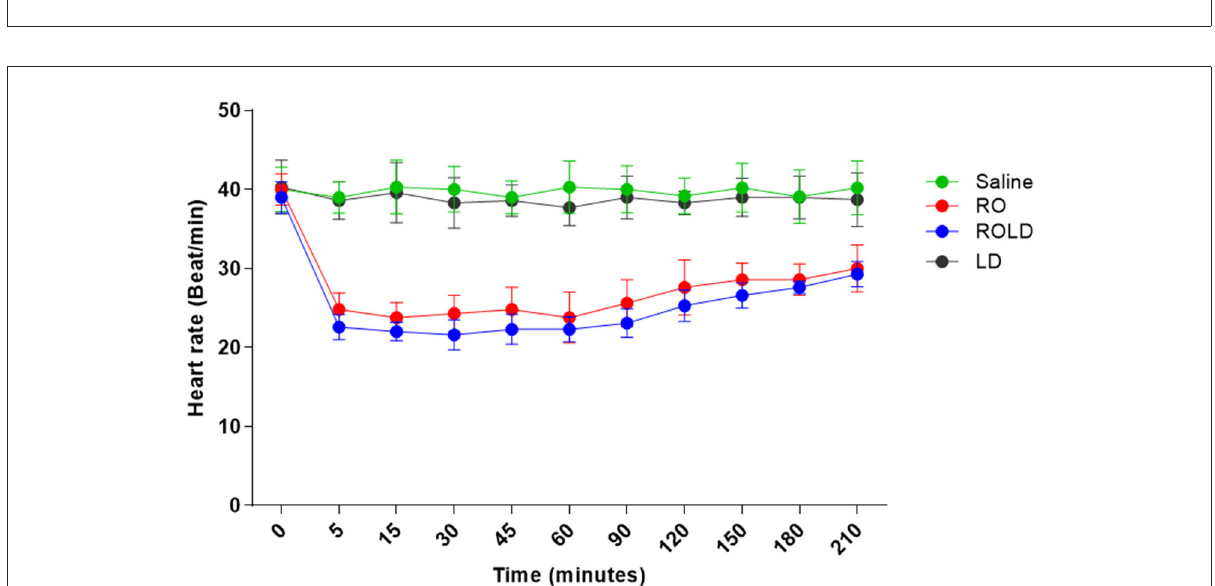
FIGURE7 Heart rate (Beat / Min.; mean and standard deviation) pre- epidural and post- epidural administration of saline ( n = 6), romifidine (RO) (50 µ g kg − 1) ( n = 6), romifidine-lidocaine (ROLD) (50 µ g and 0.30mg kg − 1) ( n = 6) and lidocaine (LD) (0.3 0mg kg − 1) ( n = 6) in donkeys. Wilks Lambda test for time x treatment, P < 0.01, indicates significant changes in respiratory rate under the effect of treatment and time. However, sphericity assumed test indicates the effect of time (within-treatment). Wilks Lambda test for time x treatment interaction P < 0.01. Sphericity assumed test for the effect of time (within-treatment), P <